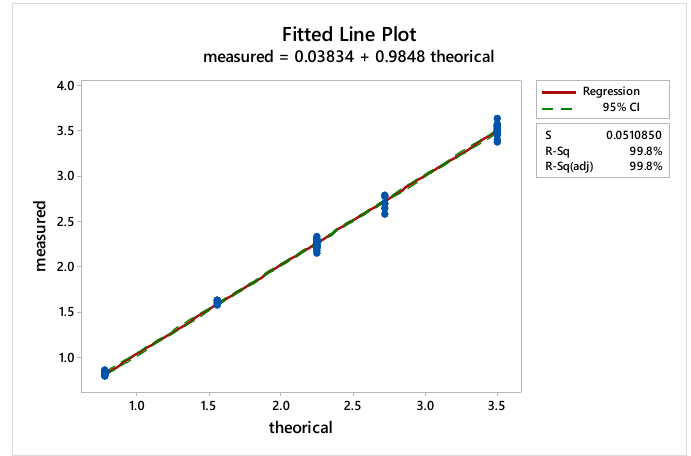
Figure A13. Sample Linearity plot for quantification of S. flexneri 6 OAg by HPAEC-PAD.